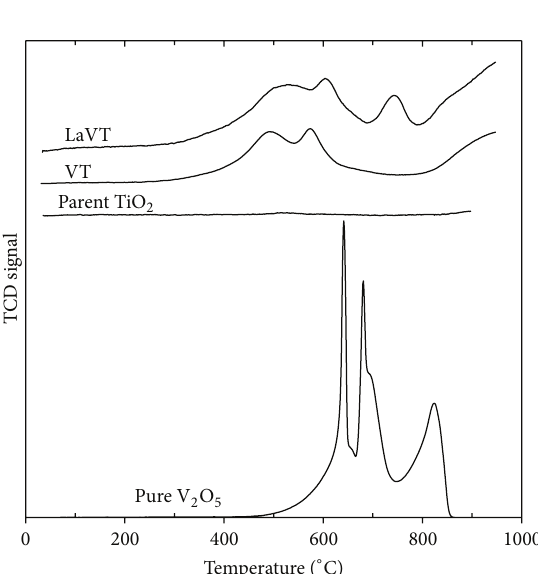
Figure 3: A comparison of H 2 -TPR spectra obtained for LaVT, VT, parent TiO 2 , and pure V 2 O 5